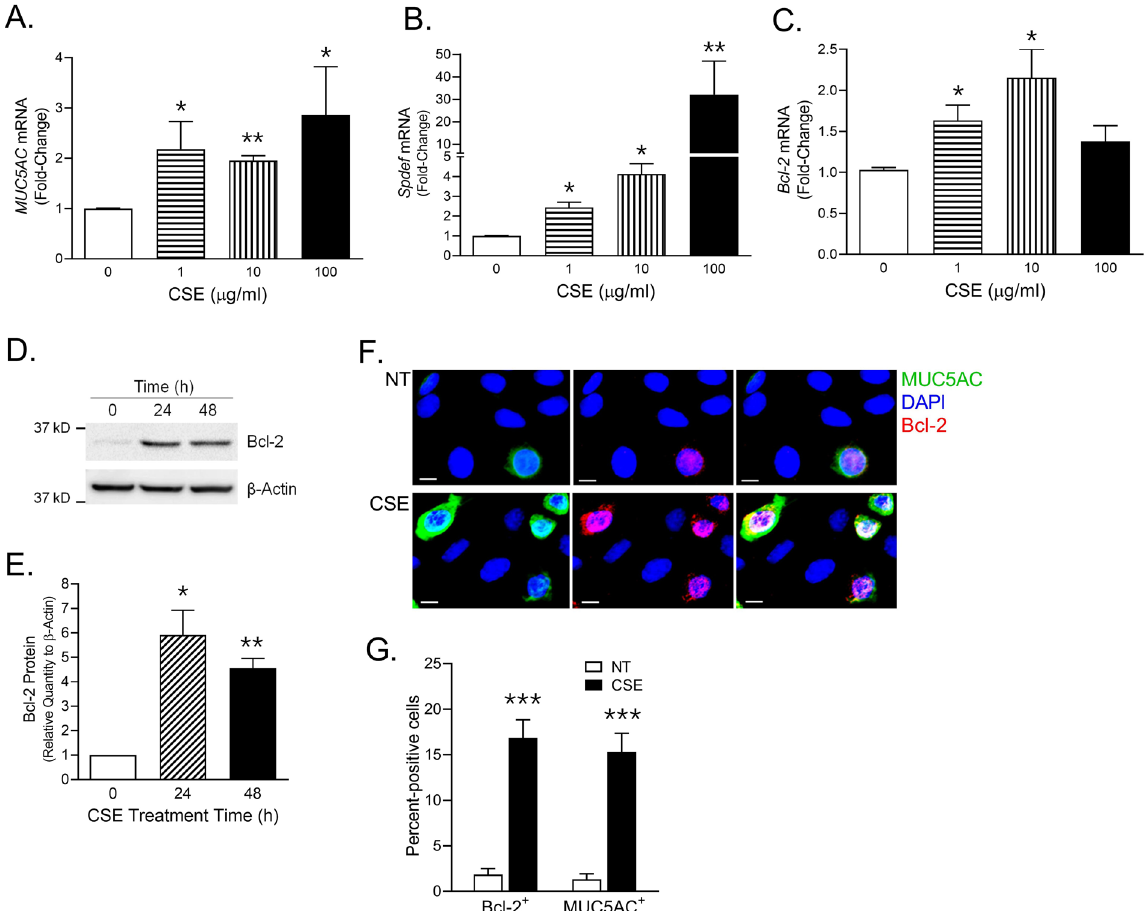
Figure 2. CS exposure induces MUC5AC, SPDEF, and Bcl-2 levels in human AEC monolayers. Primary human AECs grown in submerged cultured conditions were treated with 0, 1, 10, and 100 µ g/ml of CSE for 24 h and the mRNA levels of MUC5AC ( A ) SPDEF ( B ) and Bcl-2 ( C ) were analyzed by qRT-PCR. ( D ) Immunoblot analyses of Bcl-2 expression following CSE exposure. Differentiated human AECs were treated with 10 µ g/ml CSE and cell lysates were analyzed at 0, 24 and 48 h post CSE exposure by western blot analysis for Bcl-2 protein levels with β -actin levels detected as the loading controls. ( E ) Relative quantities of Bcl-2 protein as determined by densitometric analysis and normalized to β -actin levels. ( F ) Representative micrographs showing MUC5AC (green) and Bcl-2 (red) immunopositivity in HAECs treated with CSE or left non-treated (NT). Human AECs were treated with CSE (10 µ g/ml) for 48 h and immunostained for Bcl-2 and MUC5AC, and nuclei were stained with DAPI (Scale – 5 µ ). ( G ) Quantification of human AECs immunopositive for MUC5AC and Bcl-2 following CSE exposure. The percentage of human AECs immunopositive for Bcl-2 (Bcl-2 + ) and MUC5AC (MUC5AC + ) were calculated. Data shown as mean ± SEM (n ≥ 3); * p < 0.05; ** p < 0.01; *** p <